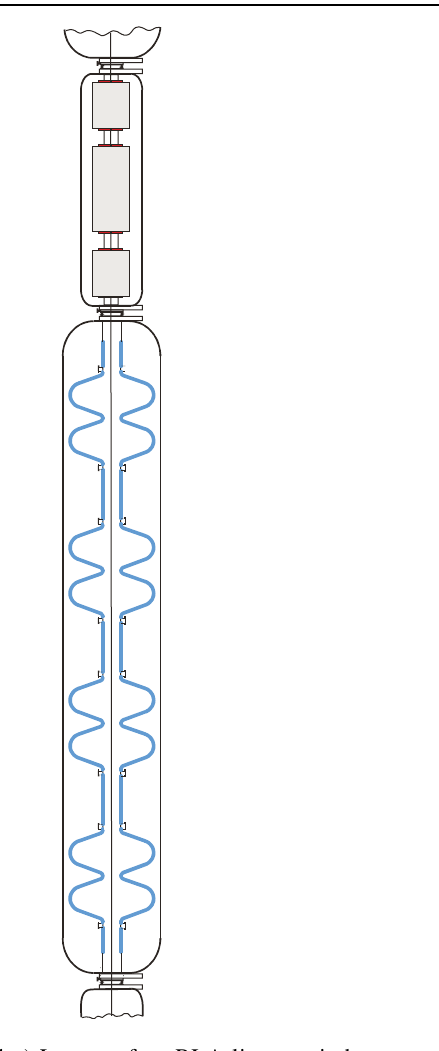
FIG. 23. (Color) Layout of an RLA linac period.